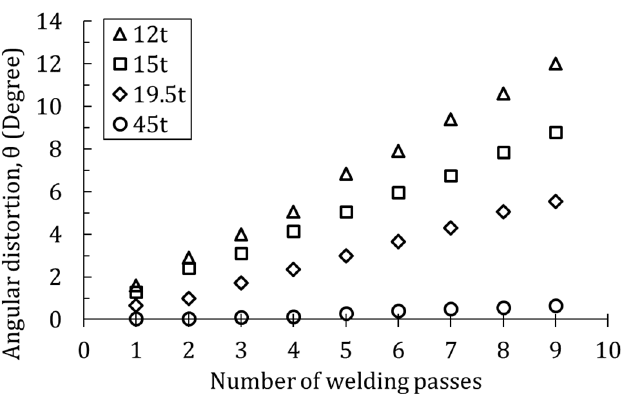
Figure 4. Angular distortion according to number of welding passes.